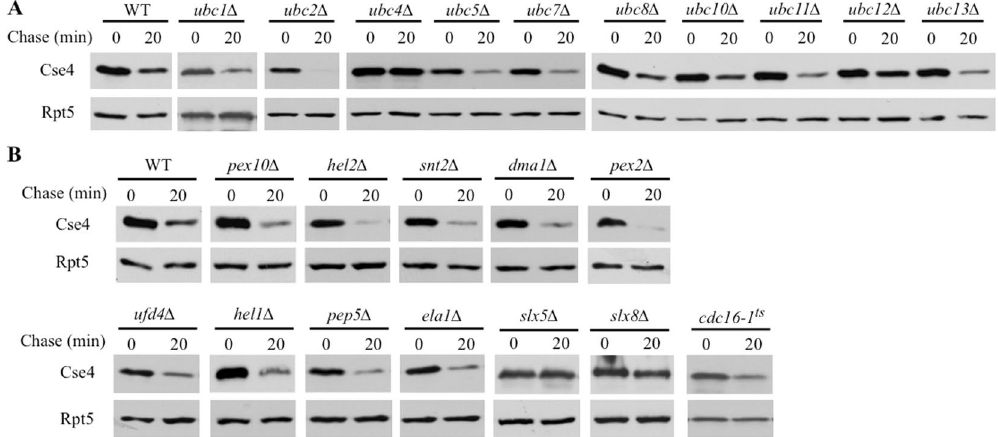
Figure 1. The involvement of Ubc4 E2 and Ubc4-associated E3s in Cse4 degradation. ( A ) Cse4 turnover is impaired in ubc4 Δ cells. Cse4 stability was examined in wild-type and E2-deficient cells by a protein expression shut-off assay. A plasmid bearing HA-tagged Cse4 was transformed into wild-type cells and 10 E2 mutants. Yeast cells expressing HA-Cse4 were grown to an OD 600 of ~1, and samples were collected after expression was turned off by cycloheximide (indicated as Chase (min). Extracts were analyzed by immunoblotting with HA antibody. Equal amounts of extracts were used and verified by western blotting with Rpt5 antibody in all of protein stability experiments (lower panels). ( B ) Efficient Cse4 degradation requires Slx5 and Slx8. Cse4 turnover in wild-type cells and 12 Ubc4-associated E3 mutant cells was determined as